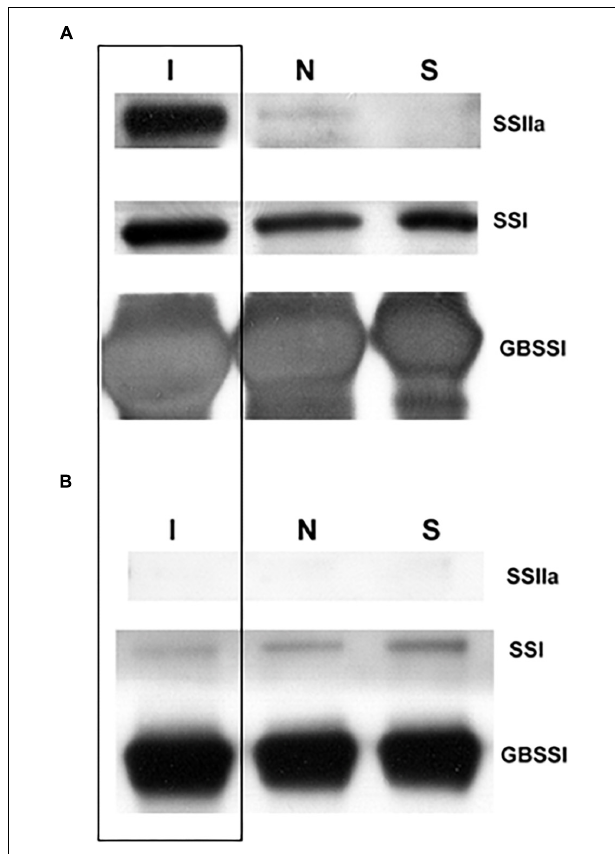
FIGURE 6 | Western blot analysis of SSIIa, SSI and GBSSI in (A) granule-bound and (B) soluble proteins of hp-SSIIa-op (SS5) (S) compared with its parent Nipponbare (N) and an indica positive control IR64 (I) (boxed) using mature grains.